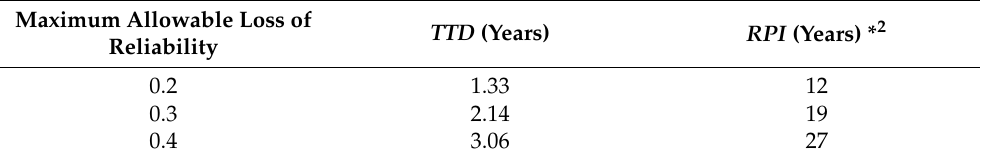
Table 5. Time to Damage ( TTD ) estimation and recommended replacement interval ( RPI ) for O-rings with HSA > 65.